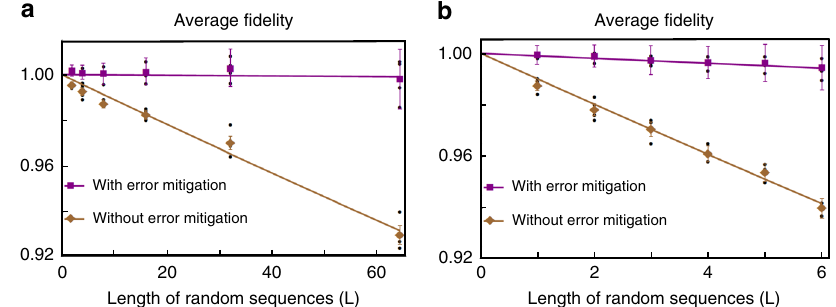
Fig. 4 Experimental data for error-mitigated quantum computation. a The single-qubit randomized benchmarking. The data points with (purple square) and without (yellow diamond) error mitigation are obtained from averaging the fi nal-state fi delitiy over different random sequences of the same length (black dots). The error bars are the SD of the average fi delities computed using the formula of uncertainty propagation. The solid lines, obtained by fi tting, show the exponential decrease of the average fi delities, indicating the physical and effective average errors per gate being (1.10 ± 0.12) × 10 − 3 and (1.44 ± 5.28) × 10 − 5 , respectively. Please note that some of the fi delities with error mitigation are larger than 1 because of the rescaling factor C > 1 (see main text and Methods) and the limited sampling for data points. Although the current protocol does not guarantee a physical outcome, the error mitigation procedure shifts the distribution of the computation result towards the true value with a large enough sampling. b The two-qubit random-circuit computation. Decay rates indicated by the average fi delity curves without and with error mitigation are (0.99 ± 0.06) × 10 − 2 and (0.96 ± 0.10) × 10 − 3 ,